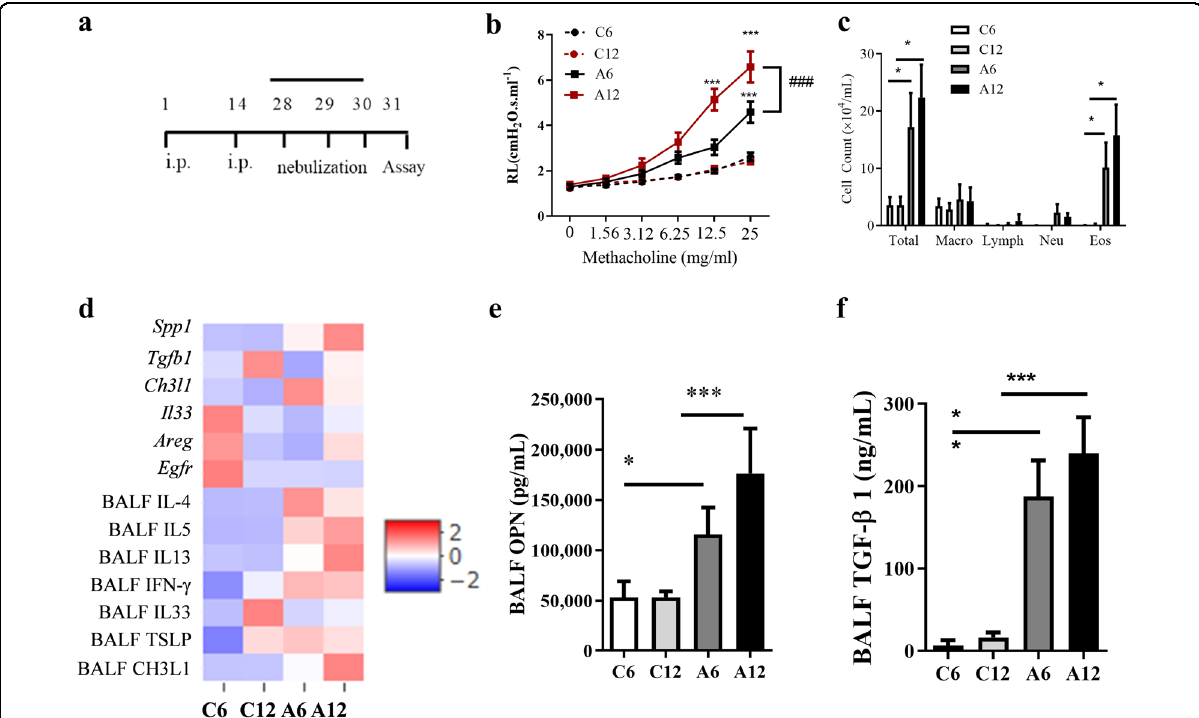
Fig. 2 Increased airway in fl ammation and AHR in older and younger mouse models of asthma. a Mice at 6 and 12 weeks old underwent the induction of asthma by using OVA/Alum and were assessed for the severity of asthma according to the described protocol. Mice were assessed for b AHR to methacholine at different concentrations (0, 1.56, 3.12, 6.25, 12.5, and 25 mg/mL). *** P < 0.001 at the respective weeks, between the negative control group (C6, C12) vs the asthma group (A6, A12); ### P < 0.001 between the asthma group at 6 and 12 weeks. c Total and eosinophil counts in BALF. Mouse lung tissues were used to analyze gene expression, while BALF was measured for in fl ammatory cytokines. d Heatmap clustering was applied to visualize the relative changes in gene expression and levels of proin fl ammatory cytokines according to onset age. BALF levels of e OPN and f TGF- β 1 were elevated with onset age. Data are presented as the means ± SEM, n = 10 for each group. * P < 0.05, ** P < 0.01, *** P < 0.001 between the groups. AHR airway hyperresponsiveness; Alum aluminum hydroxide; Areg amphiregulin; BALF bronchoalveolar lavage fl